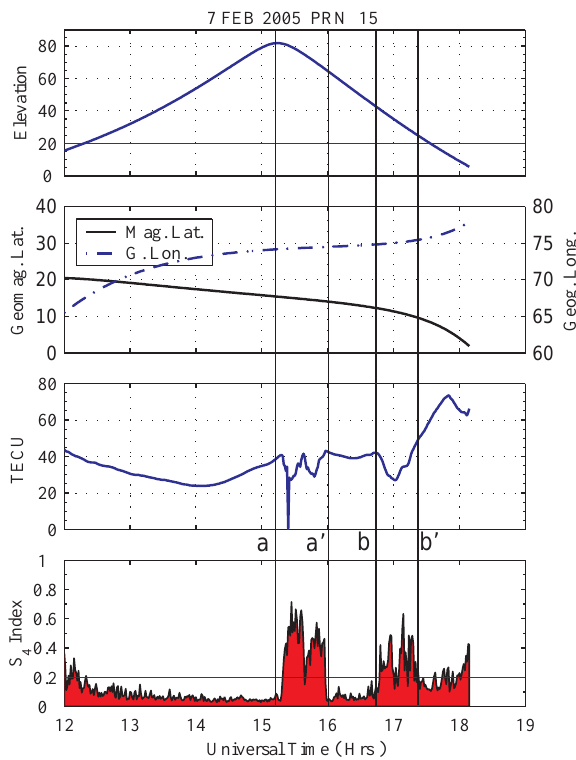
Fig. 1. Variation of TEC and S 4 index on 5 October 2004 for PRN 9. The top panel gives the satellite elevation. The second panel gives the variation of MLAT and longitude of the ionospheric pierce point (IPP) for a thin ionospheric shell at an altitude of 350km. Third panel gives the variation in the slant TEC. The fourth panel gives the S 4 index. The horizontal axis for each panel is the Universal Time (UT) shown in the last panel. Depletion in the TEC is obvious between 16:00 UT and 17:00 UT. The S 4 index shoots up with the occurrence of the depletion in TEC.